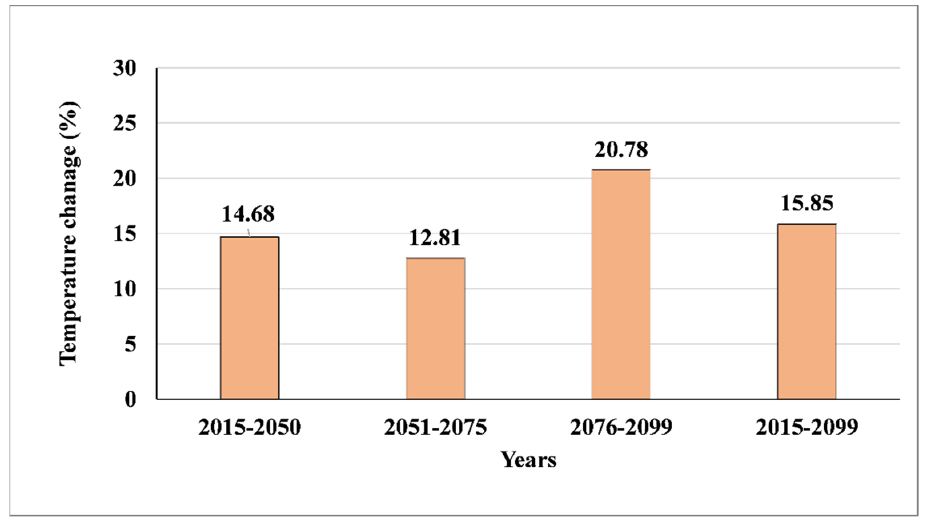
Figure 8. The annual temperature changes in Egypt between the past period (1950–2014) and the future period (2015–2099), considering only the months from March to May. Spatially, the average rainfall increases in the future at all zones with no distinctive changes (Figure 9) from 3.9 degrees to 3.2, which means all the zones show an increase of more than 3 degrees. The highest change was recorded in Alti Plano Egypt.